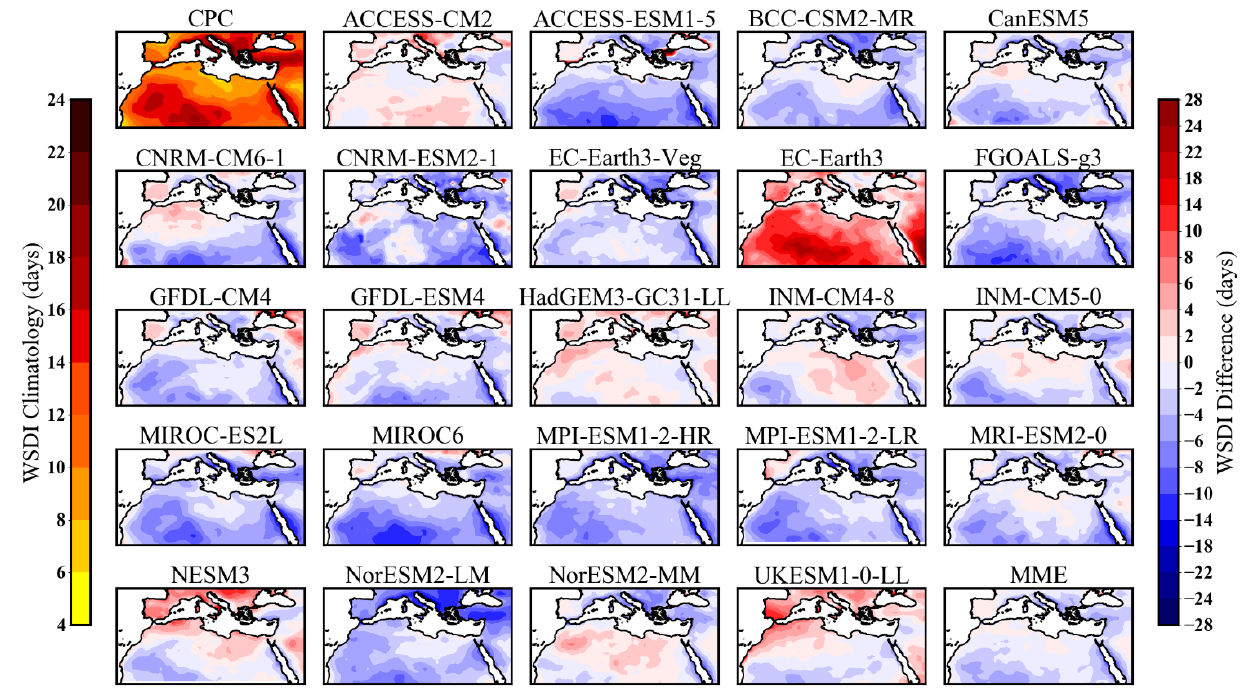
Figure 4. Spatial distribution of warm spell duration index (WSDI) difference from the CMIP6 GCMs (Table 1) and their MME during 1979–2014. The first plot shows the climatology of (WSDI) from CPC. The model difference is calculated as model (before correction) minus CPC.